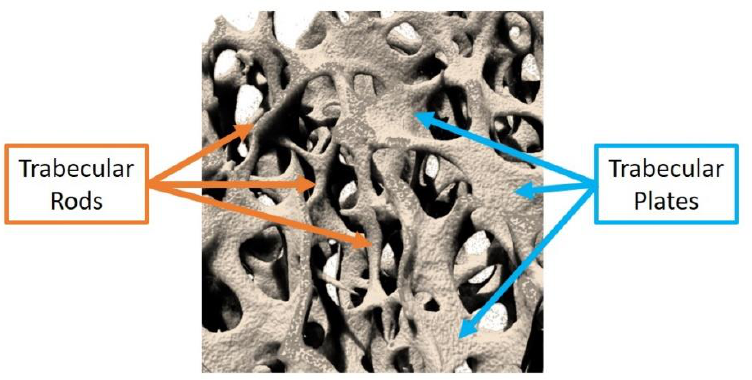
Figure 3. Rod and plate distribution in a human humeral head (3D rendering executed by the authors by scanning the bone sample with a micro-computed tomographer at a resolution of 3 µm) .